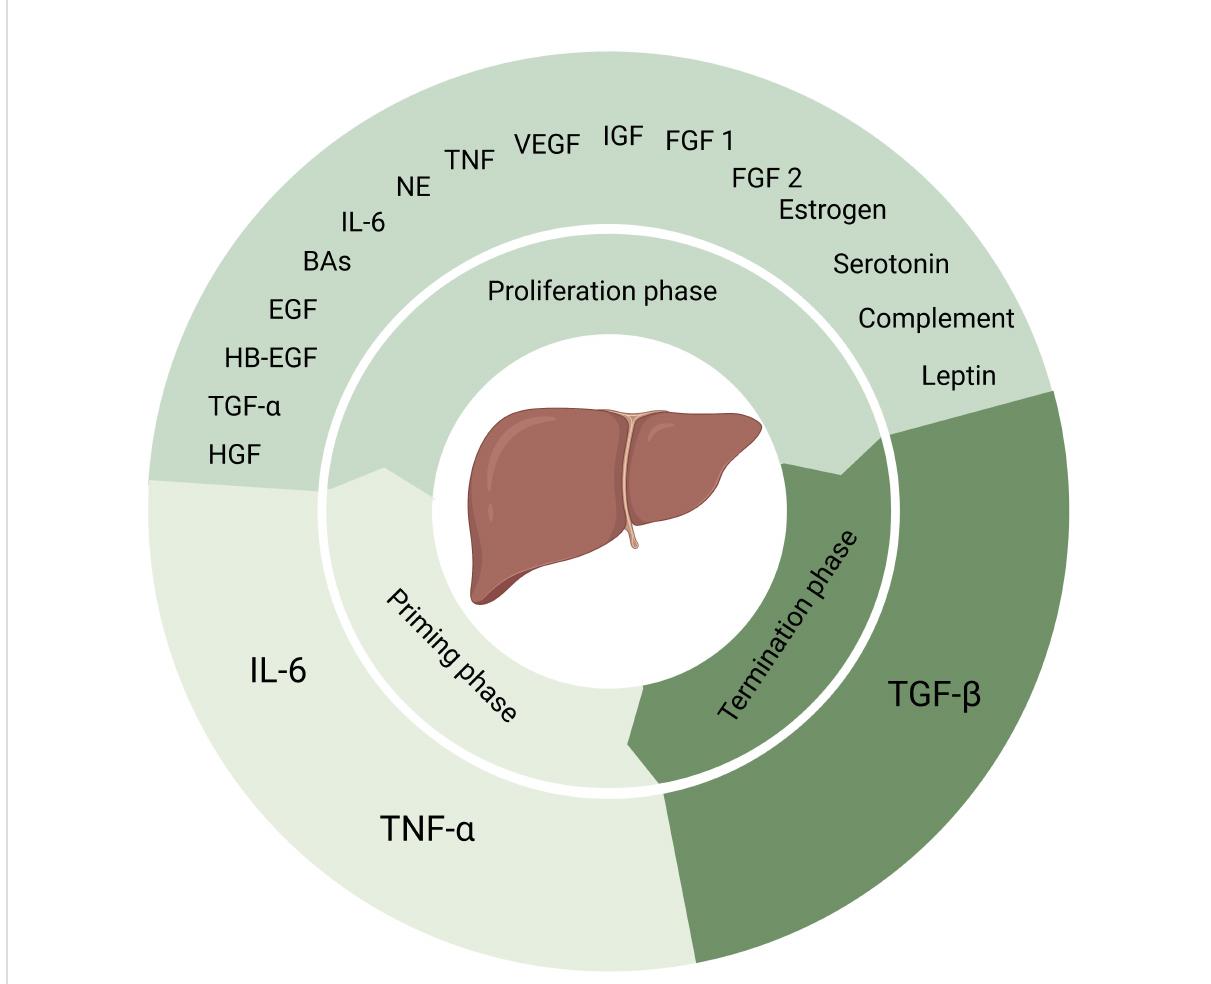
FIGURE 1 Factors that play a role in process of liver regeneration. IL-6 and TNF- a induce the priming phase. Complete mitogens including HGF, EGF, HB- EGF and TGF- a , together with auxiliary mitogens BAs, norepinephrine, TNF, IL-6, vascular endothelial growth factor, insulin-like growth factor system, estrogen, serotonin, leptin, complement, FGF1 and FGF2 involve in the proliferation phase. And the termination phase is induced by TGF- b . NE, norepinephrine, VEGF, vascular endothelial growth factor, IGF, insulin-like growth